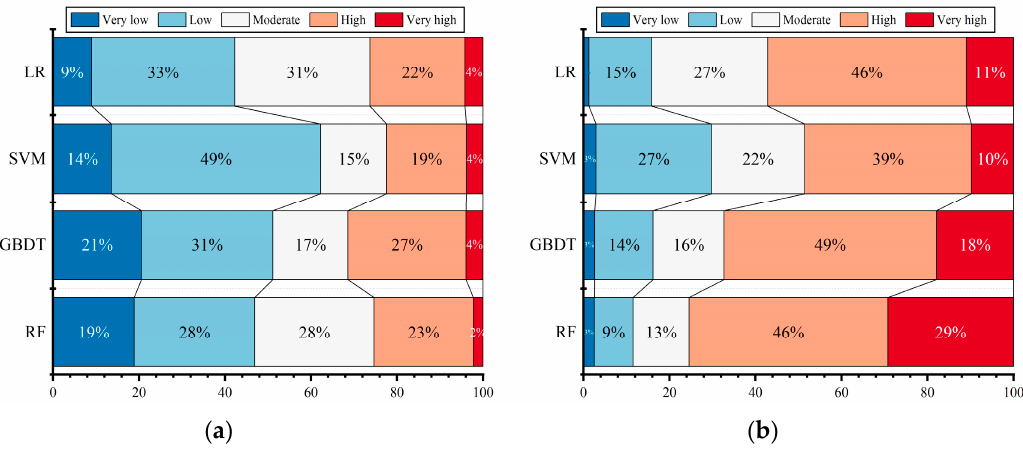
Figure 10. Percentages of area and historical hazard points in different susceptibility levels. ( a ) Percentages of area in different susceptibility levels. ( b ) Percentages of hazard points located in different susceptibility levels. The percentage of hazard points located in the very low area in the LR map is 1%.